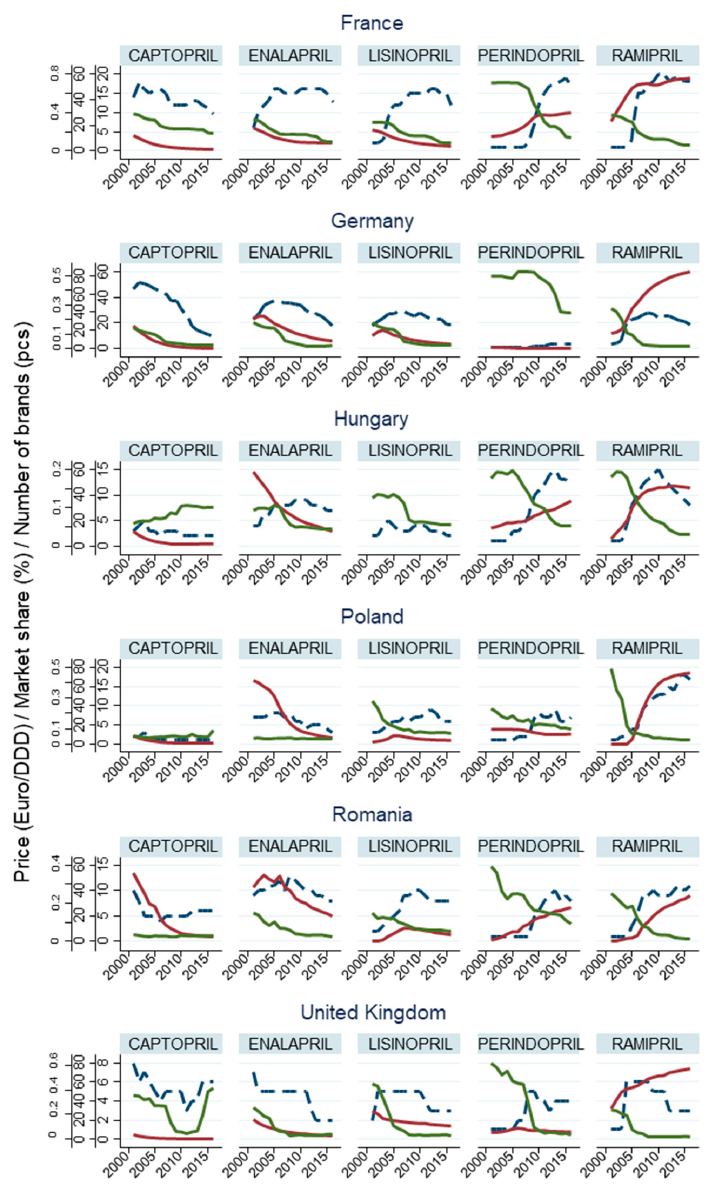
Figure 4. Changes in sales, price, and number of brands of single-drug ACE inhibitors (including the five with the most significant market share). Blue broken line (- - -): number of brands, red straight line (-): DDD-adjusted volume share, green straight line (-): price of defined daily dose.